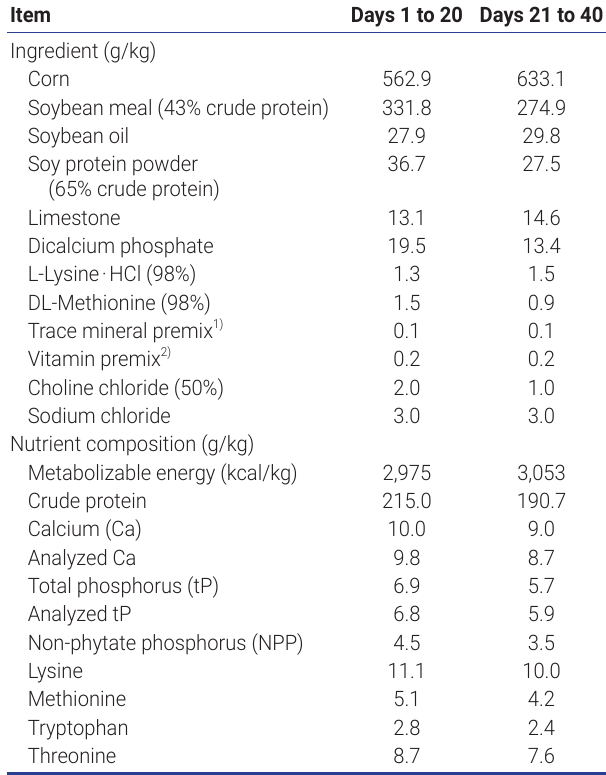
Table 1. Experimental diet composition (as-fed